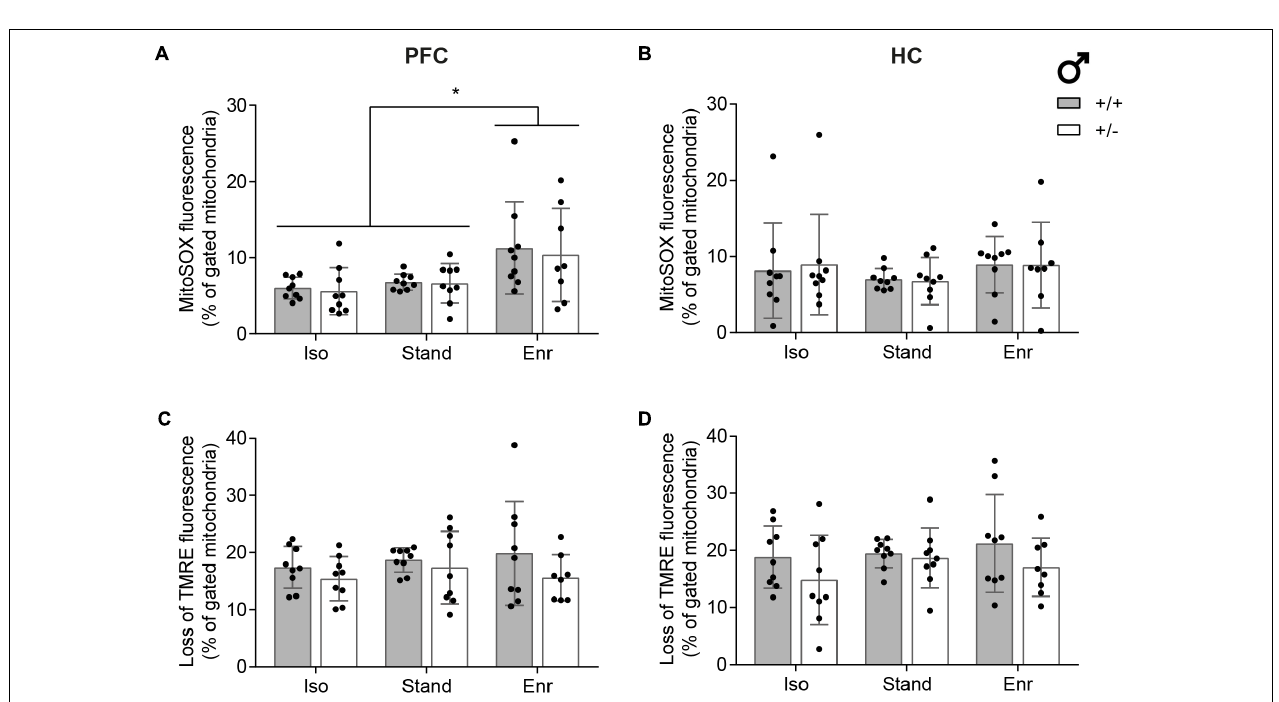
FIGURE 6 | Assessment of mitochondrial superoxide levels and membrane potential. Flow cytometric measurements were conducted with isolated mitochondria from right prefrontal cortex (PFC; A,C ) and right hippocampus (HC; B,D ) of 2-month-old male rats using (A,B) the mitochondrial superoxide indicator dye MitoSOX and (C,D) the mitochondrial membrane potential sensitive dye TMRE. The data was gated to the reference condition Cacna1c + / + -Stand in each group of six and is displayed as mean ± SD ( n = 8–9). Statistical significance is highlighted by an asterisk ( ∗ ). +/+, wildtype Cacna1c + / + (gray bars); + / − , heterozygous Cacna1c + / − (clear bars); Iso, isolation; Stand, standard housing; Enr,